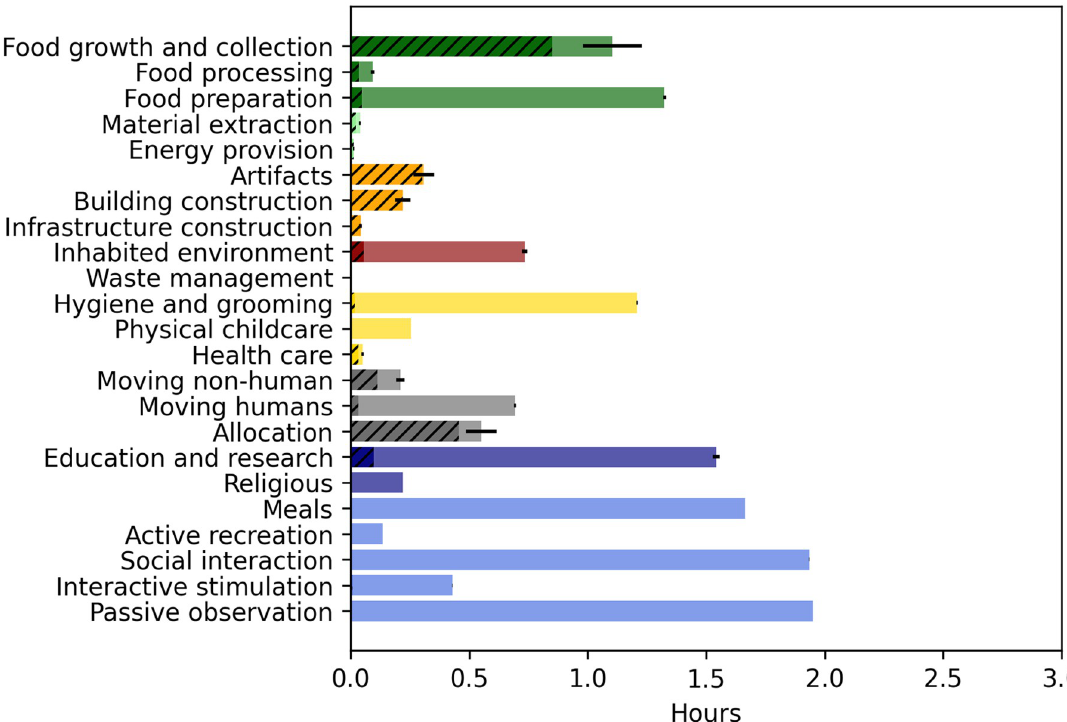
Fig 6. Time use in India using the MOOGAL. As in Fig